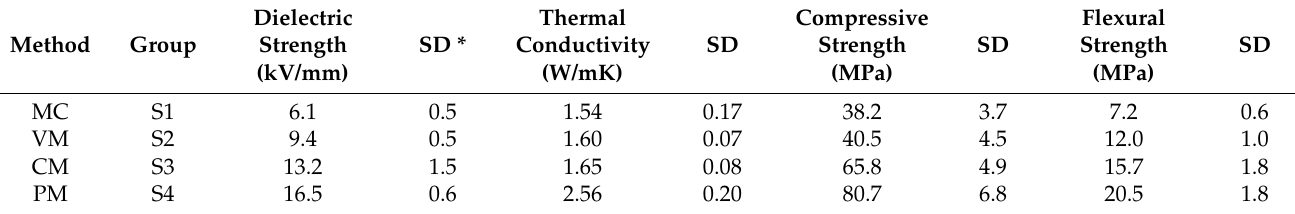
Table 3. Average electrical, thermal and mechanical properties of the PWC composites